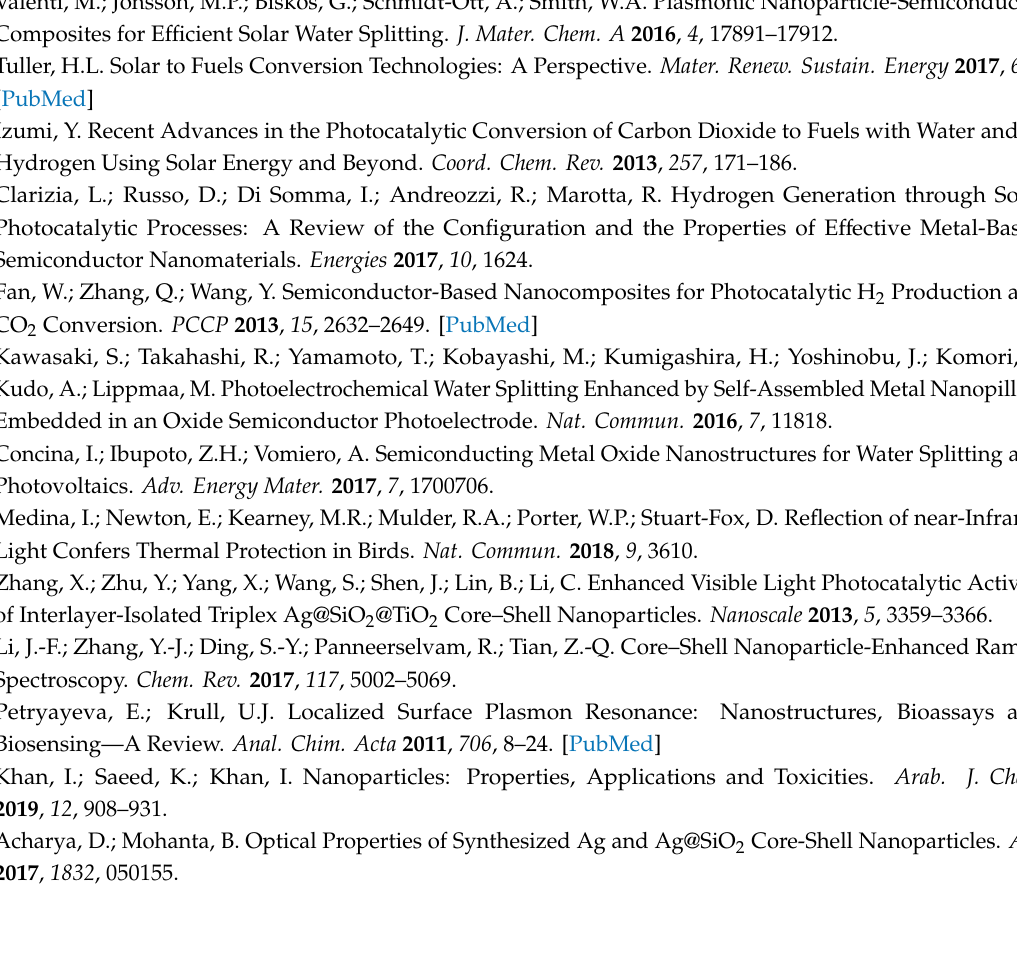
Table S1: EDX-Derived Composition of GS-NSs with Di ff erent LSPR Extinction Peaks, Figure S1: SEM images of silica-coated GS-NSs with di ff erent LSPR peak positions. (a–c) GS-NS (500), (d–f) GS-NS (700), and (g–i) GS-NS (900) with ~2, ~10, and ~15 nm, respectively, Figure S2: STEM images and corresponding EDX line scan spectra of SiO 2 -coated GS-NSs with (a, b) 2 nm, (c, d) 10 nm, and (e, f) 15 nm silica shell, Table S2: EDX-Derived Composition of the SiO 2 -Coated